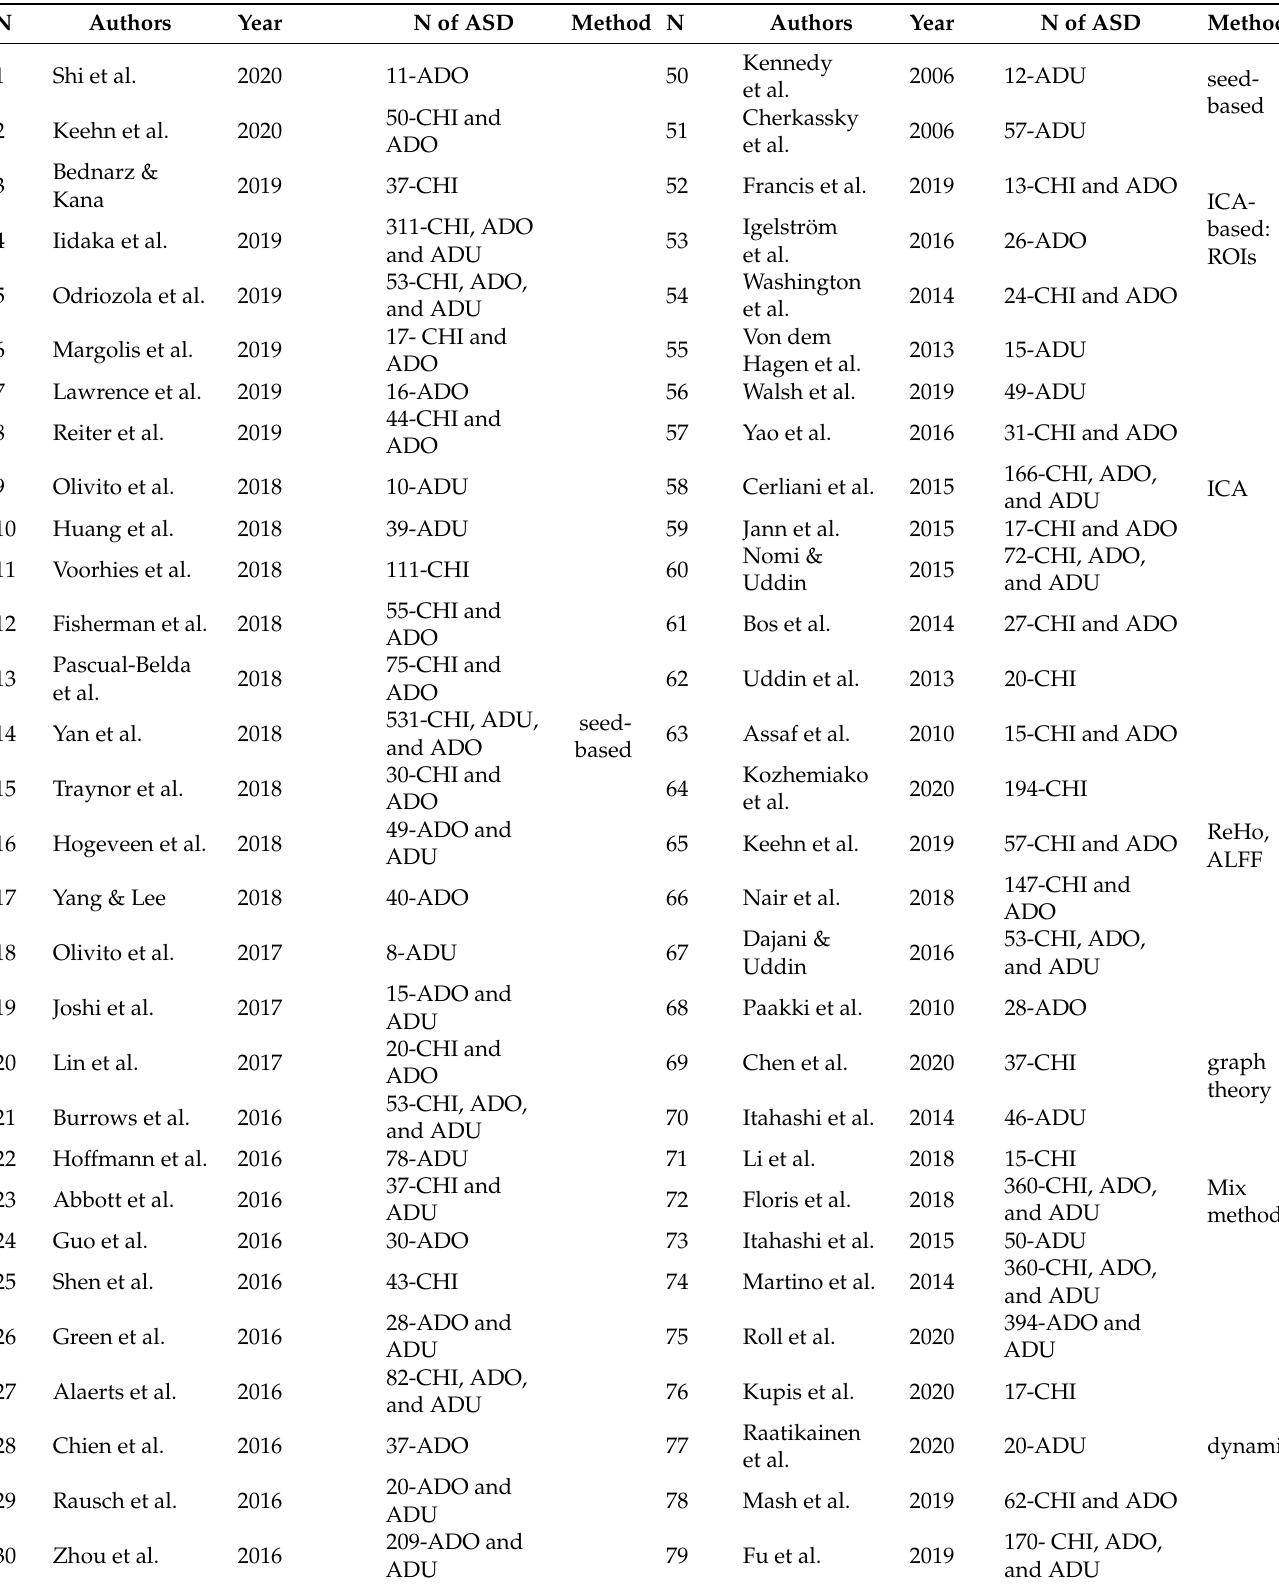
Table 2. Characteristics of resting state fMRI studies in individuals with